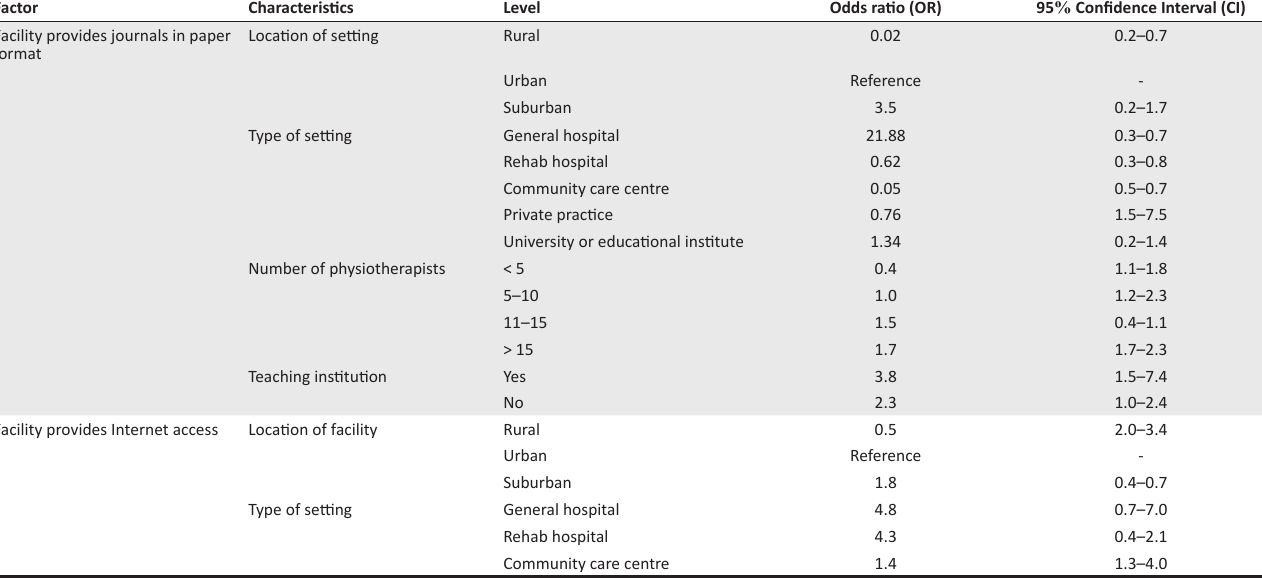
TABLE 5: Relationship between organisational characteristics and organisational factors and evidence-based physiotherapy practice. Factor